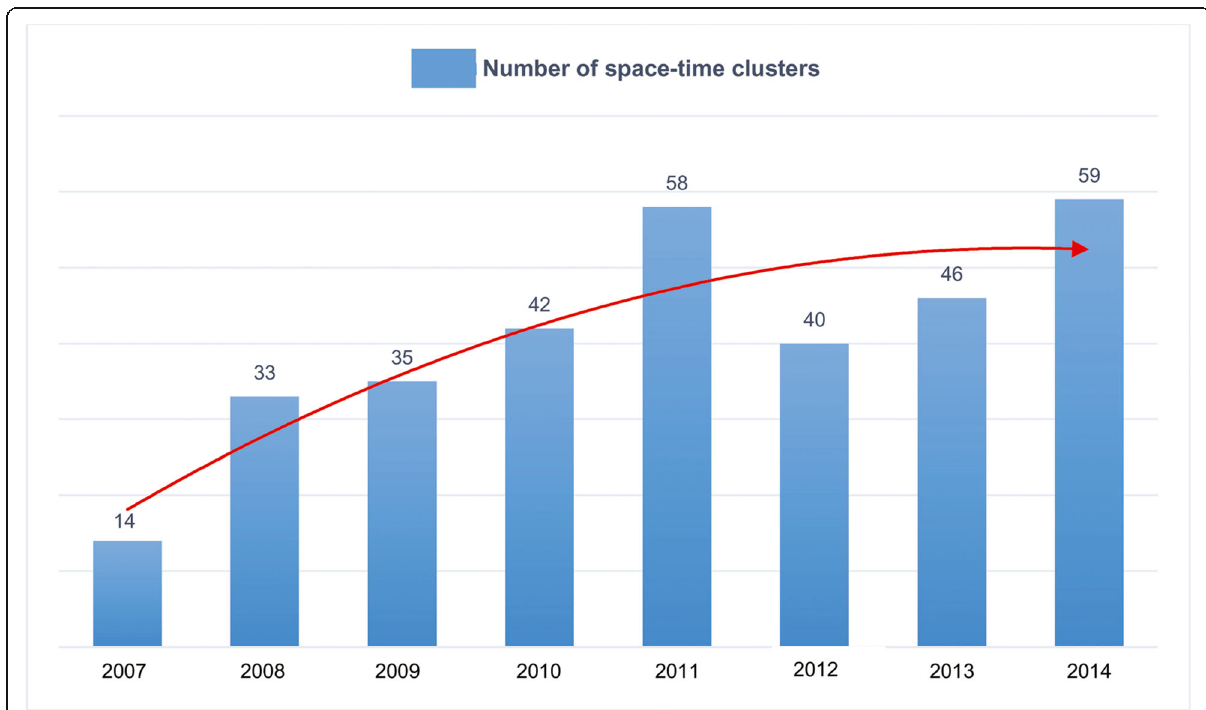
Fig. 5 The number of space-time clusters during the study years. The red line represents the second-order polynomial curve showing an overall increase in the numbers of